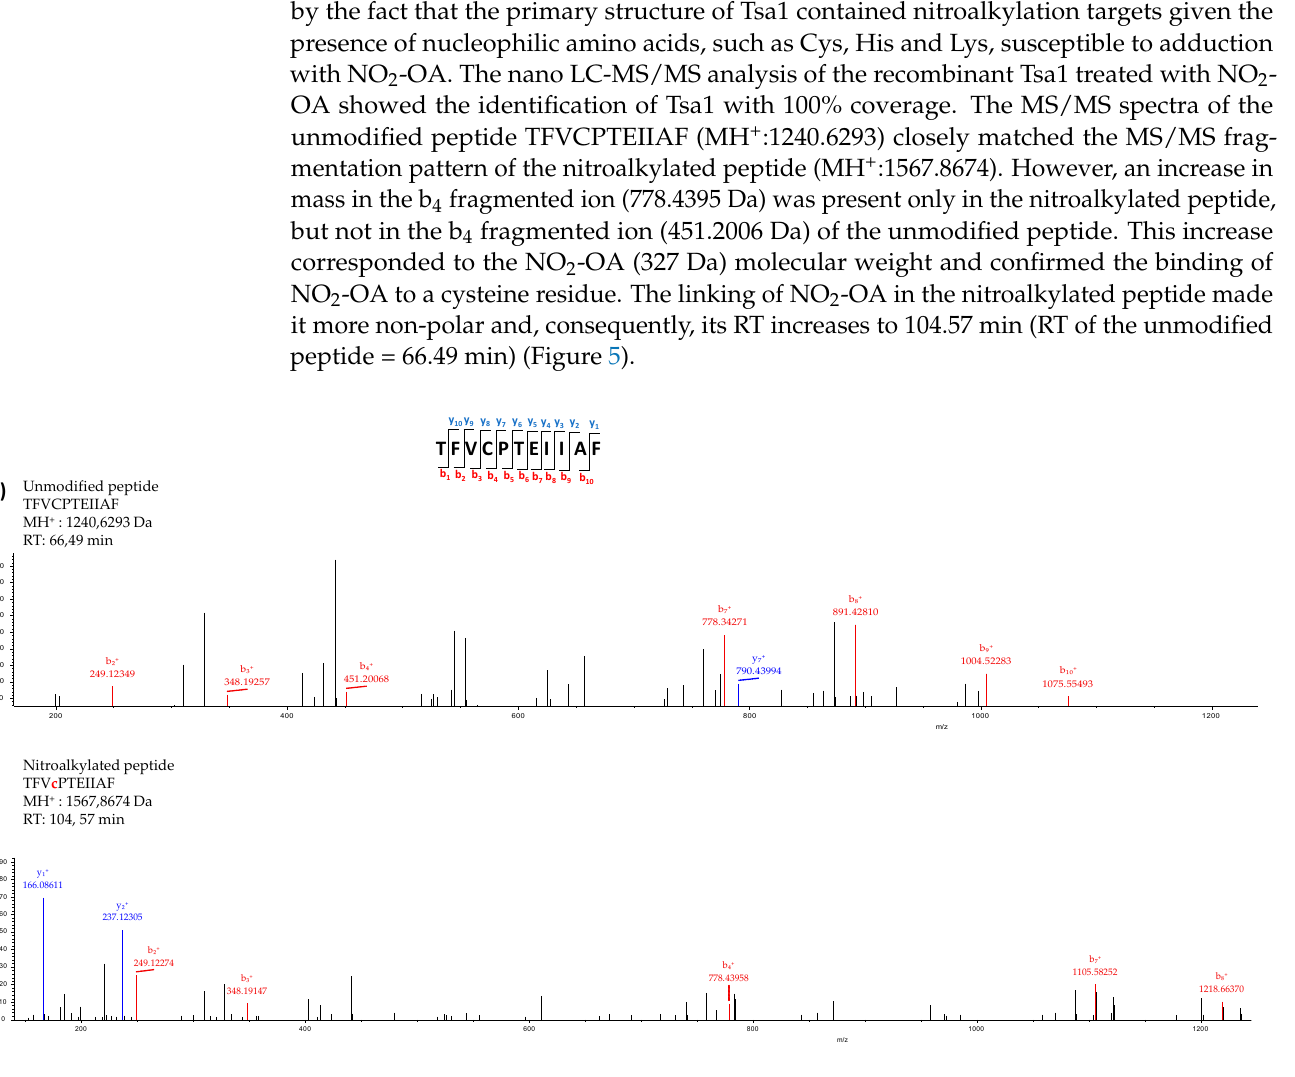
Figure 5. Comparison of the unmodified ( A ) and nitroalkylated ( B ) MS/MS spectra of one of the peptides identified after treating the recombinant Tsa1 with NO 2 -OA. Fragmentation of the precursor ion of the peptide TFVCPTEIIAF generated a series of peptide fragments called either “b” if the charge was retained at the N-terminus or “y” if the charge remained at the C-terminus. The subscripts indicates the charge of ions.